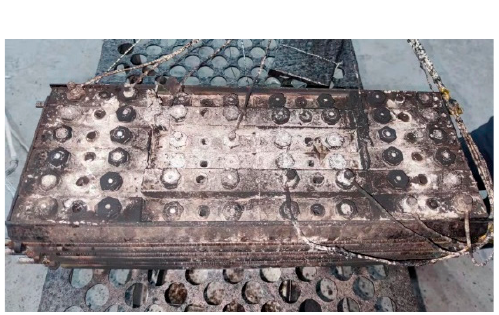
Figure 12. Photograph of the LIB pack after the combustion